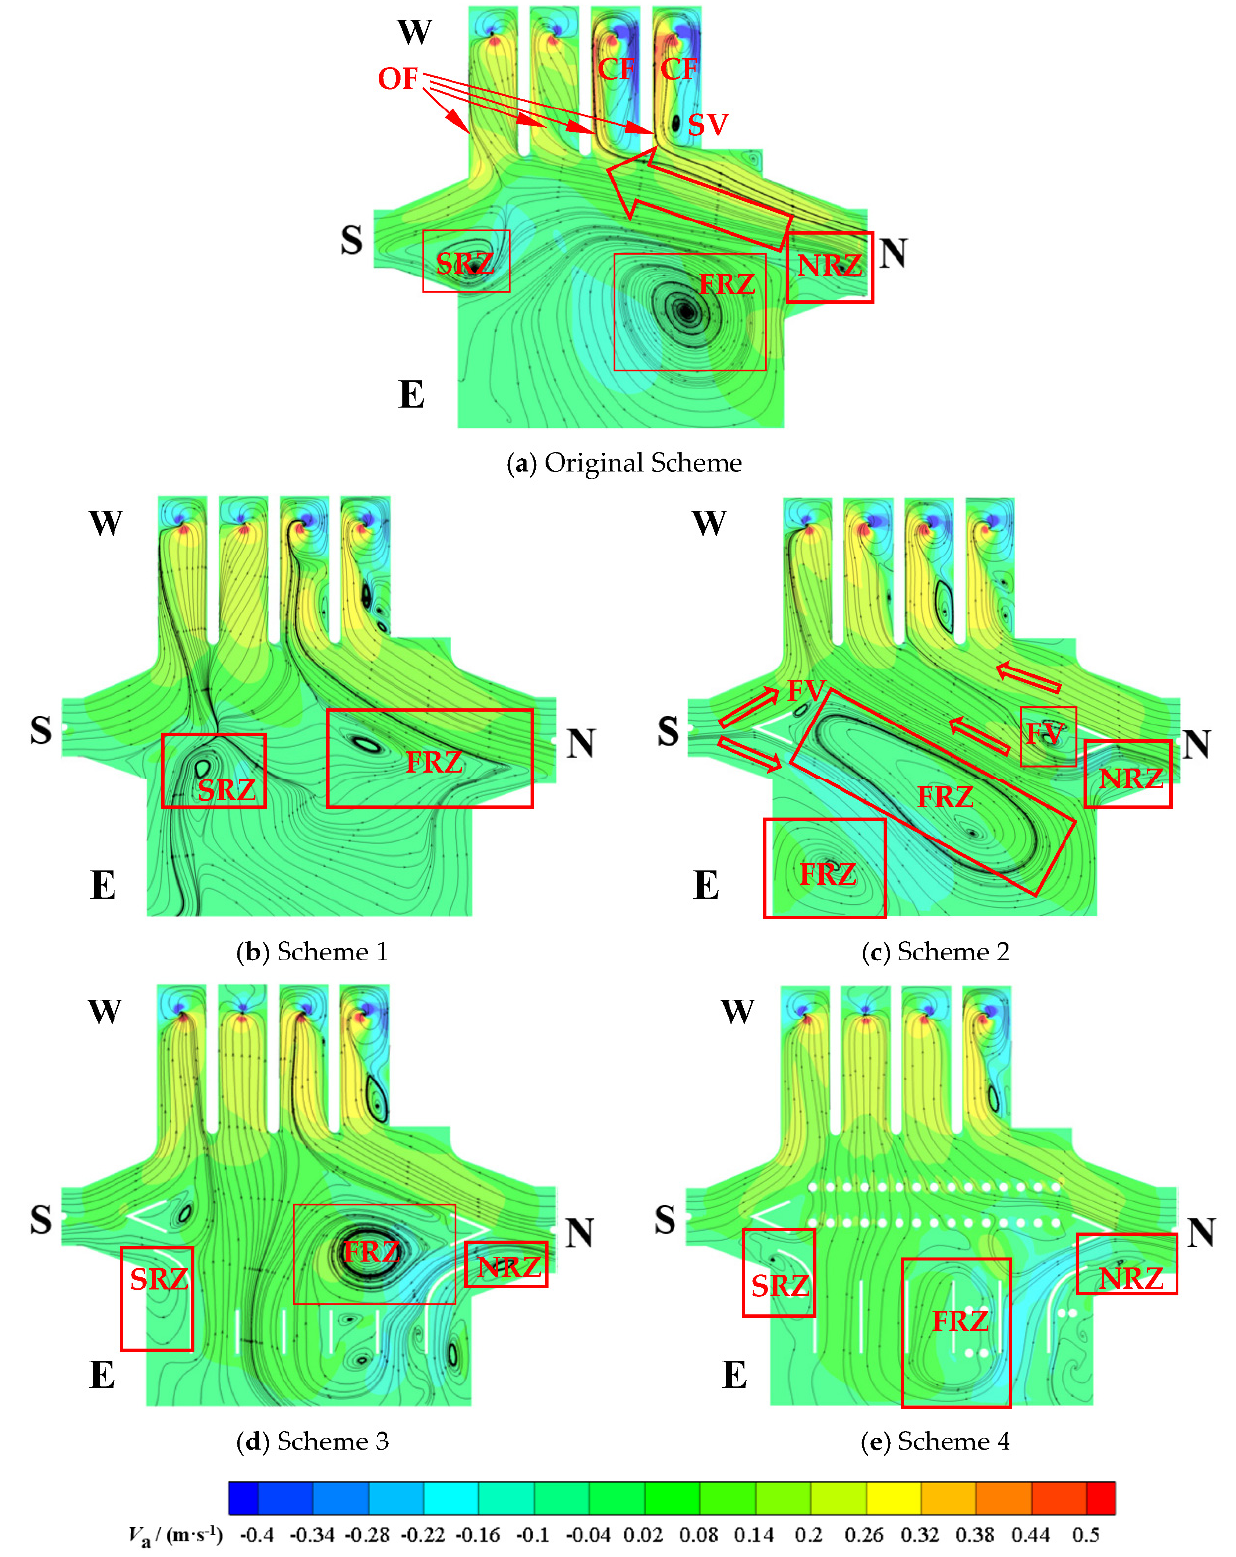
Figure 7. Surface streamline and axial velocity contour chart.